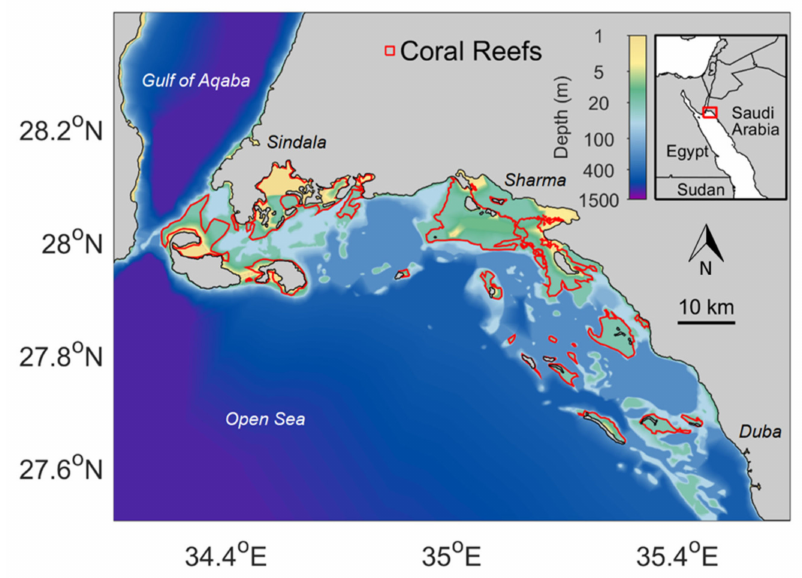
Figure 1. Bathymetry of the Northern Red Sea surrounding NEOM. The areas examined in this paper, the Gulf of Aqaba, Sindala, Sharma, the Port of Duba and the open sea, are marked on the map. The red lines represent the peripheries of the main coral reef